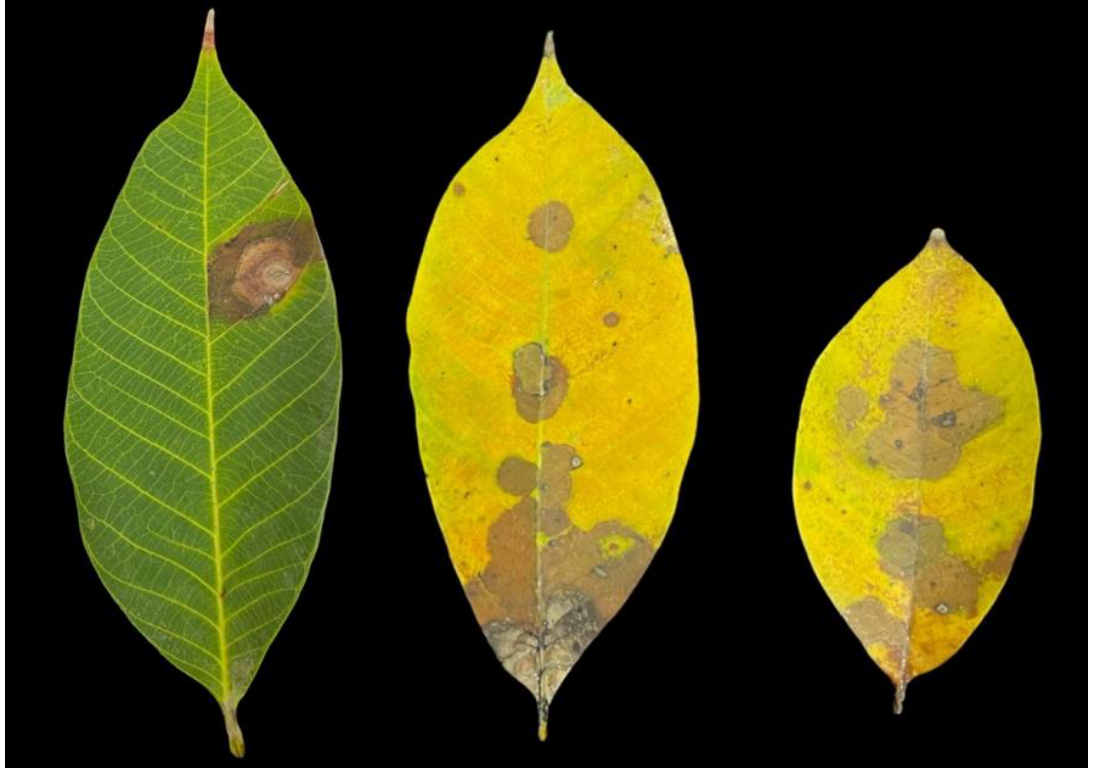
Figure 1. Disease symptoms of leaf blight disease on rubber trees.